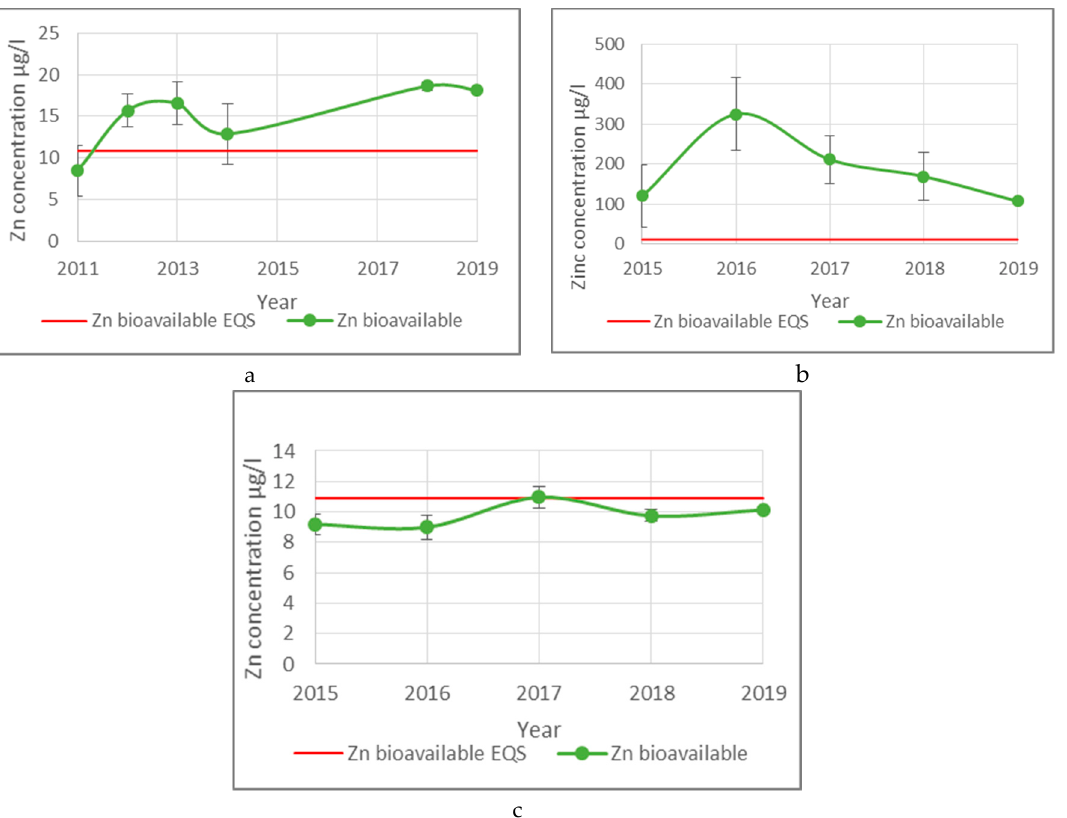
Figure 8. Annual mean bioavailable Zn levels for the river Teign at Chudleigh bridge ( a ), beadon Brook ( b ) and Preston ( c ), compared to the bioavailable EQS for Zn. Data calculated from EA water quality archive [8].